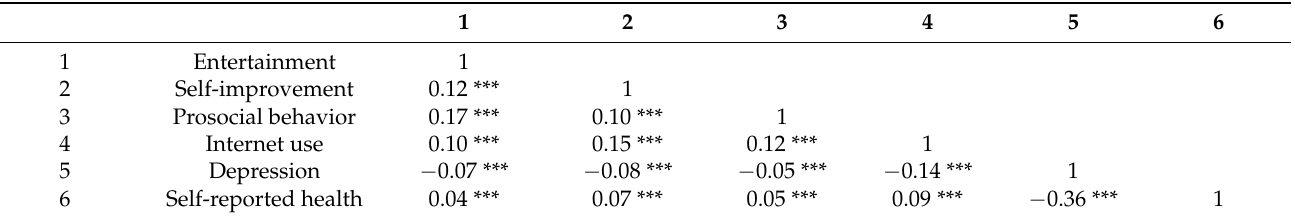
Table 3. Correlation analysis of variables in Sample 2 (N =